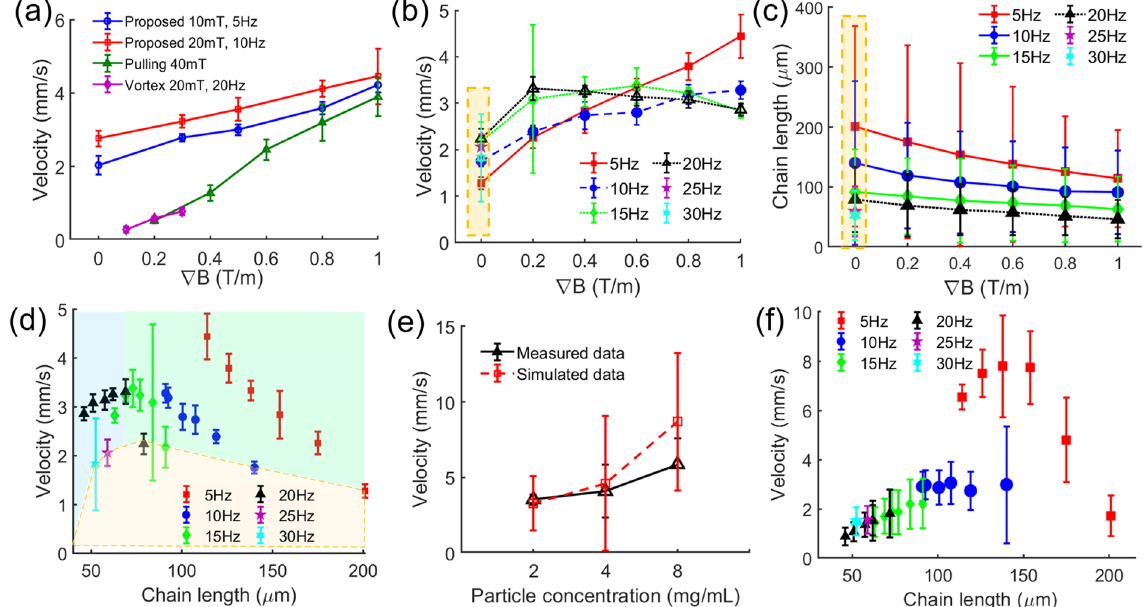
Figure 5. Locomotion test of nanoparticles. ( a ) Experimental results of different particle control methods including conventional tumbling motion, gradient pulling motion, vortex-like swarming motion, and proposed enhanced tumbling motion. ( b ) Measured moving speed of enhanced tumbling motion at constant 10 mT field with various rotating frequencies (5, 10, 15, 20, 25, and 30 Hz) and gradient field strengths (0, 0.2, 0.4, 0.6, 0.8, and 1 T/m). c Estimated length of chains under conditions similar to ( b ). Orange bounded regions in ( b , c ) are data for conventional tumbling motion with zero gradient field. ( d ) Plot of moving velocity with respect to chain length; orange region represents data for conventional tumbling motion, green is gradient-active region, and blue is inactive region for both rotating frequency and gradient. ( e ) Measured and simulated data of moving speed of chain-like cluster with different particle concentrations. ( f ) Simulation results of moving speed dependent on rotating frequency and gradient under conditions similar to ( b , c , d motion. The enhanced tumbling motion shows a virtually linear proportion to the change in the field gradient. At 20 mT and 10 Hz (red line), the moving velocity of the clusters linearly increases from 3.2 ± 0.17 mm/s at 0.3 T/m to 4.5 ± 0.8 mm/s at 1 T/m; at 10 mT and 5 Hz (blue line), the velocity is slightly lower, i.e., from 2.8 ± 0.1 mm/s at 0.3 T/m to 4.2 ± 0.2 mm/s at 1 T/m. The results of the gradient pulling of magnetic clusters are demonstrated by the green line (Fig. 5a). The moving velocity of the magnetic clusters by gradient pulling motion accelerates faster than that of the enhanced tumbling motion. This is evident because only the magnetic pulling force exerted on the cluster causes this motion; hence, the significant change in locomotion speed is in response to the field gradient variation. Gradient pulling is less efficient than the enhanced tumbling motion with a maximum speed of 3.8 ± 0.53 mm/s at an applied field of 40 mT and a gradient of 1 T/m. In the conventional tumbling motion of particle chains, frequency performs a vital function in the moving velocity. In the enhanced tumbling motion, as indicated by the gap differences between the red, blue, and green lines (i.e., the contribution of rotating frequency) and the differences among the lines (i.e., the contribution of the field gradient), the contribution of the changing field gradient to the increase in the moving velocity is higher than that of the rotating frequency. The results of the moving velocity caused by the vortex-like swarm are represented by the purple line in Fig. 5a. The locomotion mechanism of the vortex-like swarm is described in “Materials and methods” section in supplementary material and Fig. S5. In this measurement, the vortex of particles was first generated by apply- ing an in-plane rotating field with an amplitude of 20 mT and frequency of 20 Hz. The gradient fields, which vary from 0.1 to 0.3 T/m, are then applied to the vortex for locomotion. As mentioned in the Supplementary Material, the higher field gradient breaks the vortex structure. The moving velocity of the vortex-like structure is proportional to the gradient field and can achieve a maximum speed of 0.78 ± 0.1 mm/s at 0.3 T/m. These results demonstrate the improvement in the enhanced tumbling locomotion efficiency, which is approximately 20% higher than that of the gradient pulling motion using both magnetic and gradient fields. It is also virtually twice the locomotion speed of conventional tumbling motion at 1 T/m, and more than five times faster than the vortex-swarming motion.